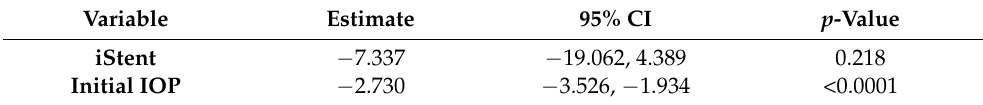
Table 5. IOP reduction multivariate analysis.